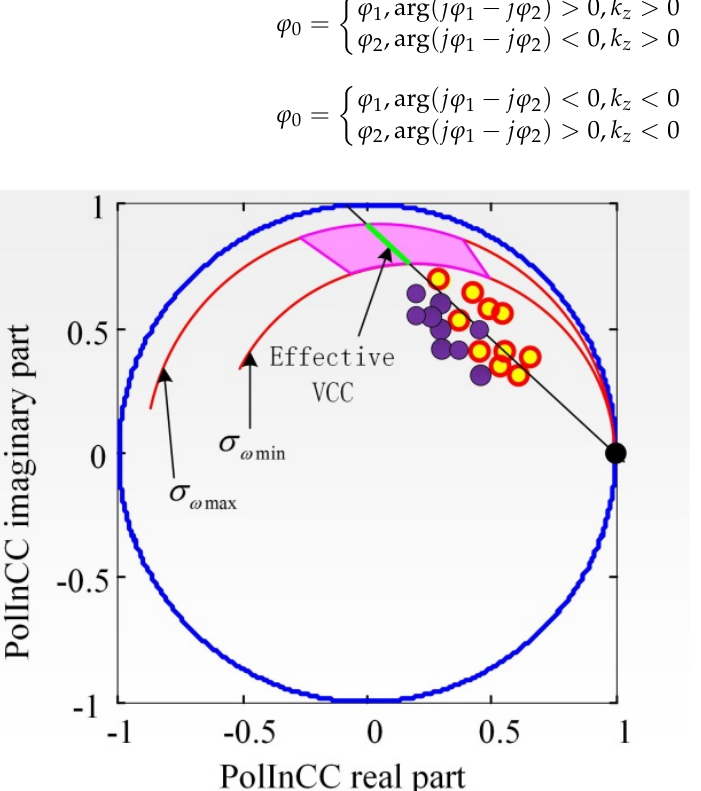
Figure 5. Schematic diagram of forest canopy height estimation process using X−band data.